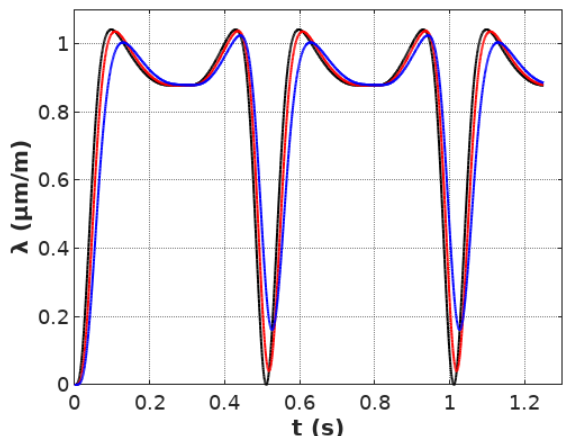
1 1 µ m µ m 1 1 , a 2 = −90.9 𝜇𝑚 , B switch = , a 2 = − 90.9 , 𝑚 𝑇 2 𝑚 𝑇 m m T T 2